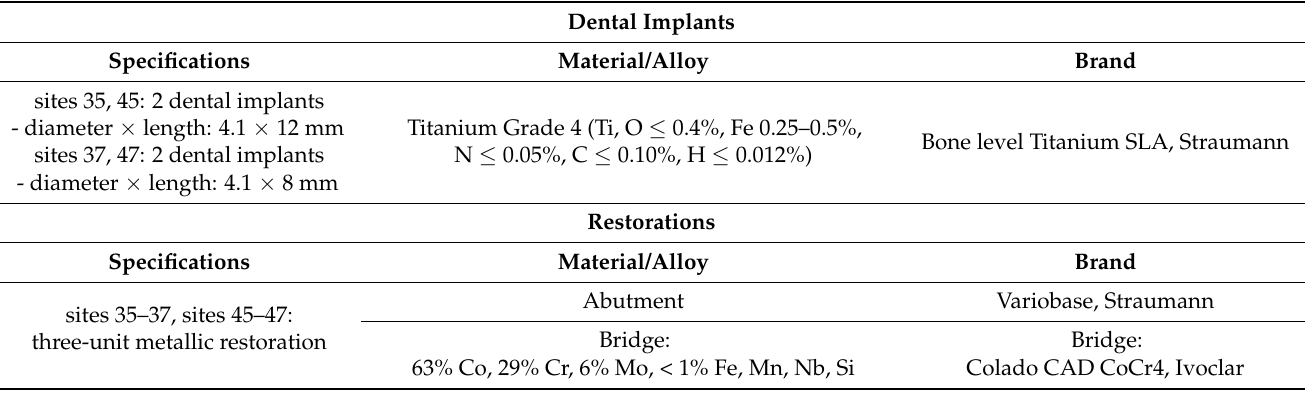
Table 1. Specifications of dental materials used in this study.